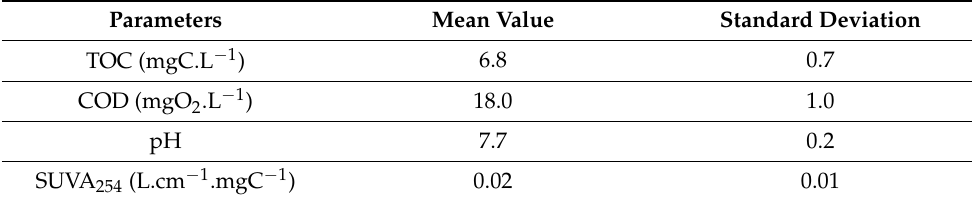
Table 2. Global parameters of the WWTP effluent.